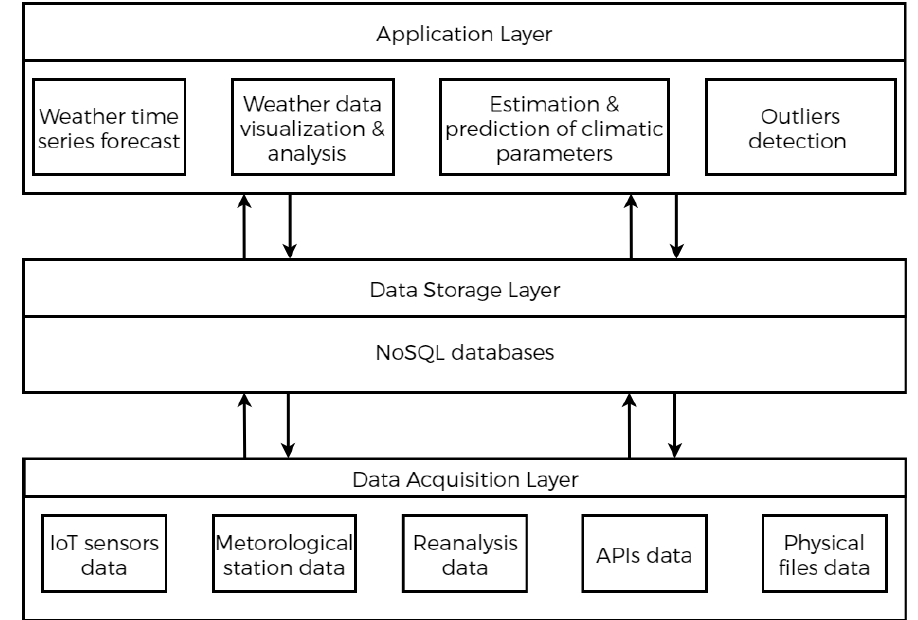
Figure 3. The layered architecture of the